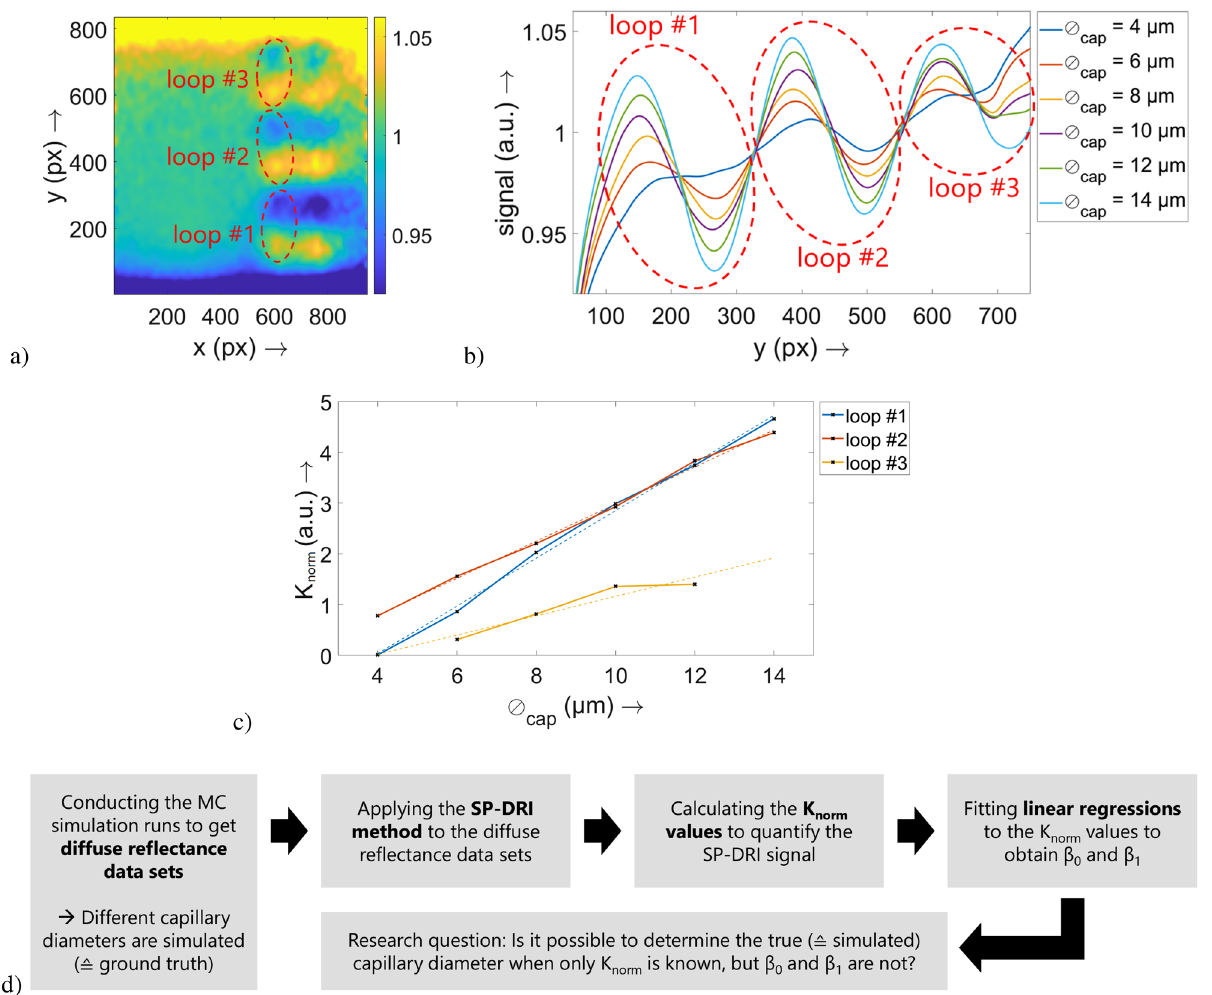
Figure 2. Exemplary illustration of the data processing procedure. As described, in the last step of the SP-DRI method two diffuse reflectance data sets are divided one by another pixel by pixel. The result of this division is shown for one set of optical properties and one capillary diameter value (here: ∅ cap = 14 µ m in ( a ). For the remaining capillary diameter values, such a data set is also existing. These data sets are then intersected parallelly to the y axis at x = 610, resulting in the graph shown in ( b ). Per capillary diameter, the three capillary loops (each located at the inflection point between a local maximum and the subsequent local minimum of the SP-DRI signal curve) at this x position are visible. A K norm value can be calculated per capillary diameter and loop; these are finally plotted (solid lines and markers) in ( c ) together with the fitting curves of the linear regressions (dashed lines). For each regression, there is one parameter set β0β0 (intercept) and β1β1 (slope). The data set belonging to the third capillary loop exhibits two missing values. In ( d ), a flowchart of this data handling is provided together with the hypothesis resulting from